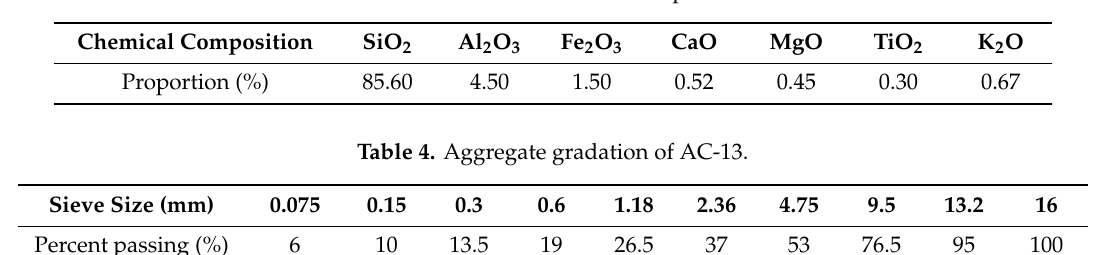
Table 3. Diatomite chemical composition.